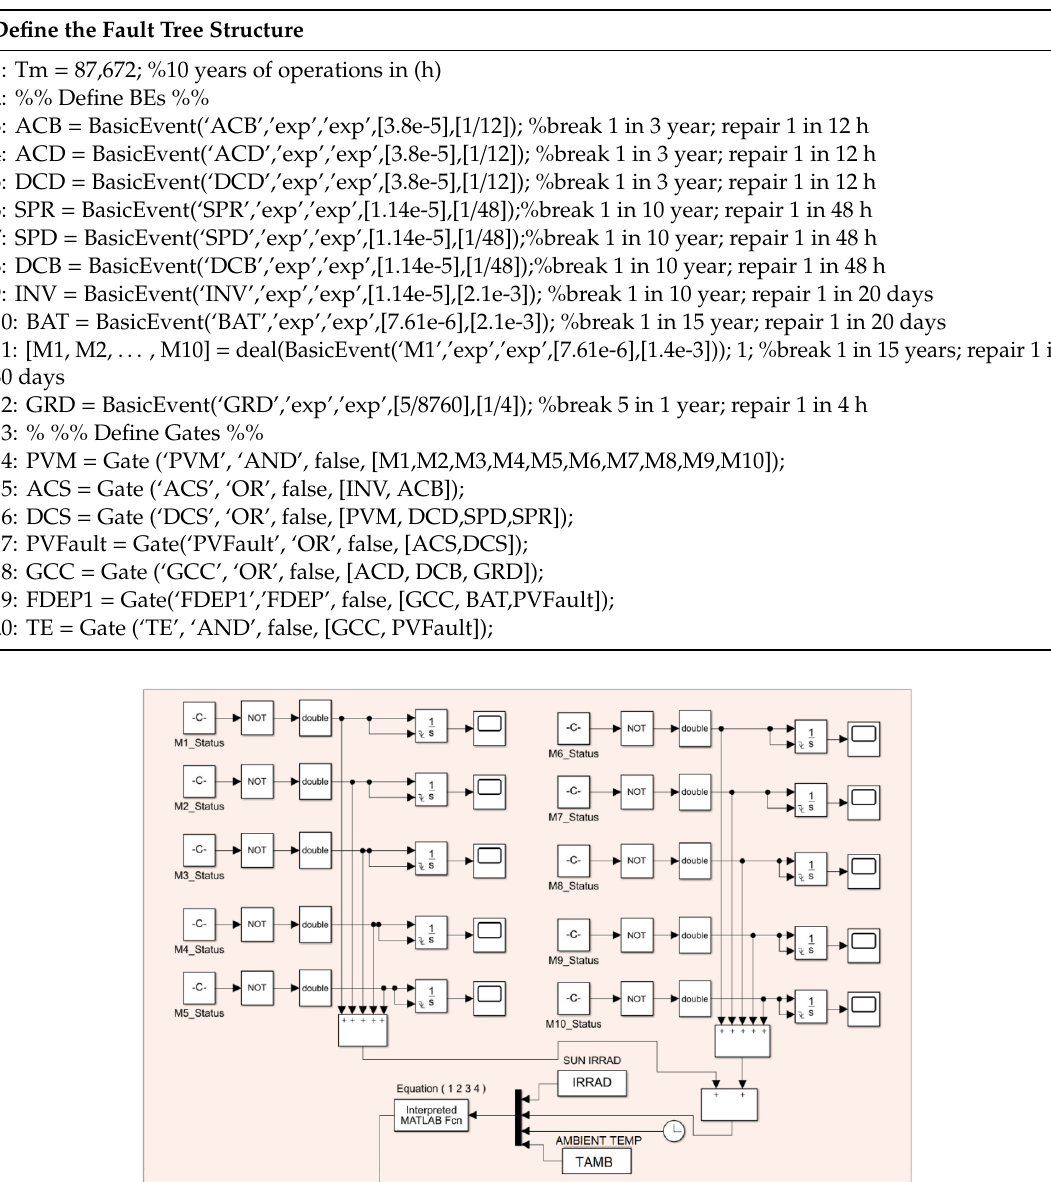
Table 6. DFT model syntax with the SHyFTOO library.